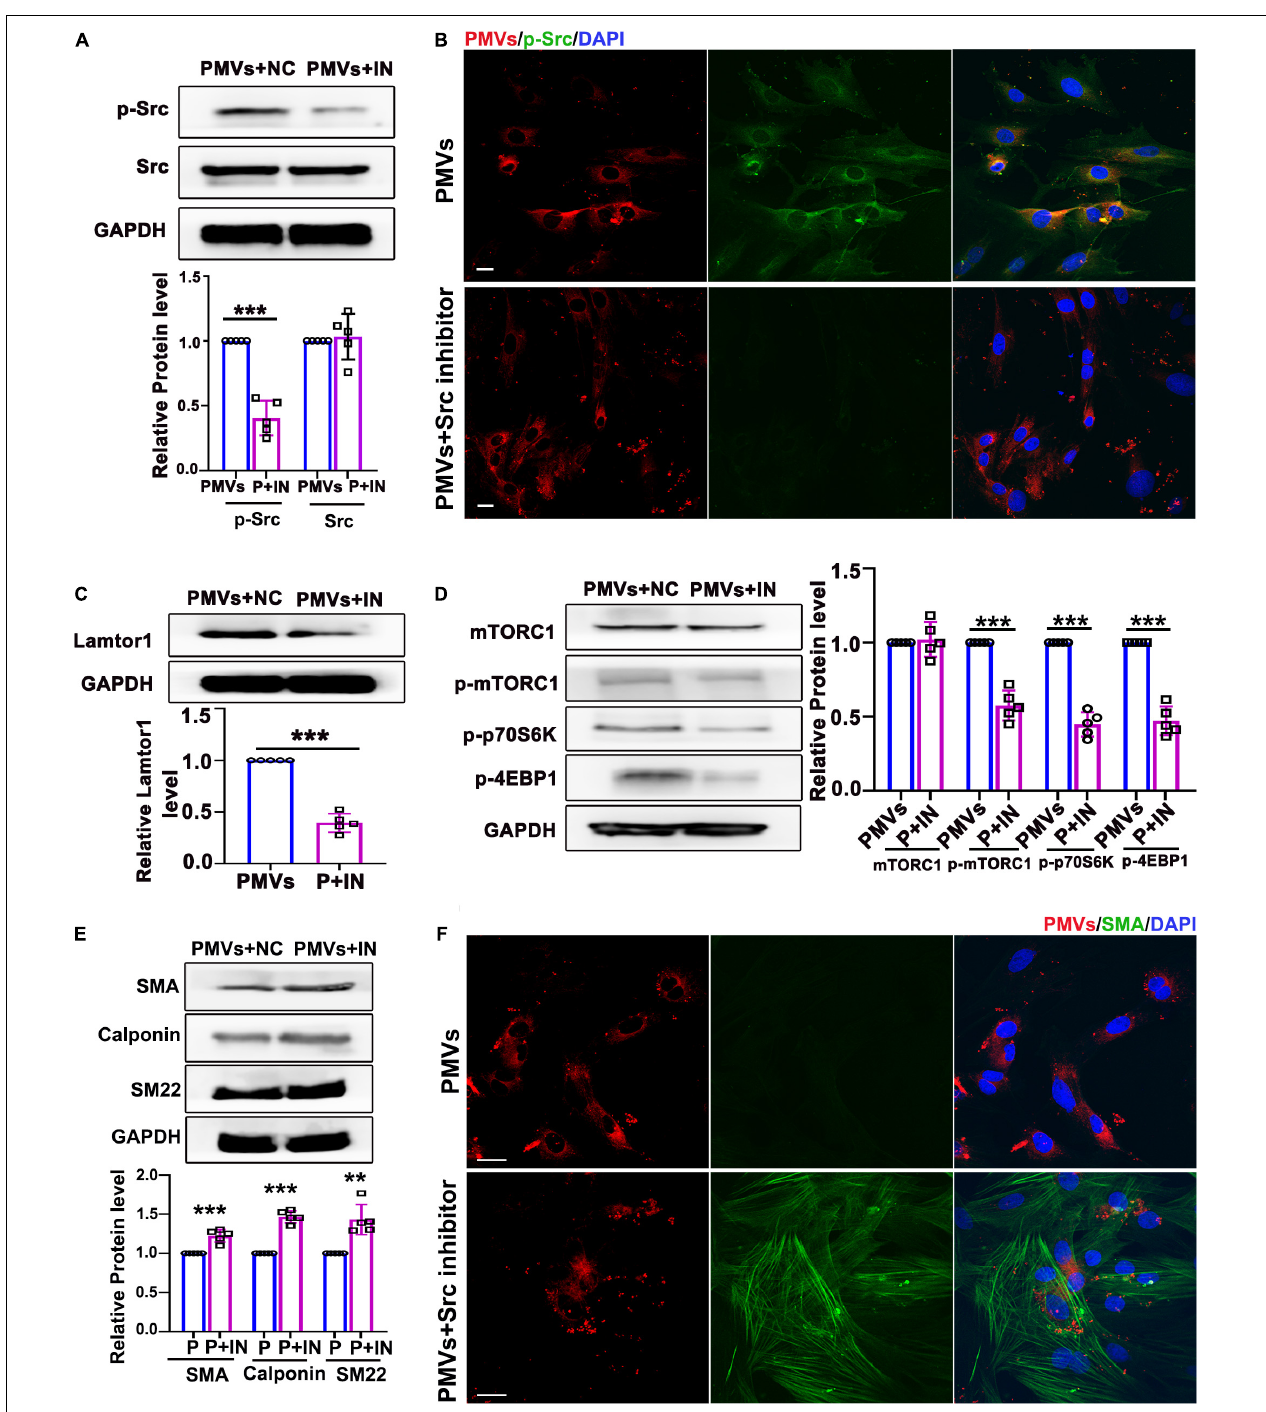
FIGURE 4 | Inhibition of p-Src repressed VSMC dedifferentiation via decreasing Lamtor1 expression and mTORC1 activity. (A) Src inhibitor (IN) decreased the phosphorylation of Src induced by PMVs, while did not change the expression of total Src ( n = 5). Data represent mean ± SD . *** P < 0.001. (B) Immunofluorescence staining confirmed that the phosphorylation of Src (green) was decreased after incubated with Src IN. Nuclei were counterstained with DAPI (blue). Scale bars: 50 µ m. (C) Src IN suppressed the protein expression of Lamtor1 induced by PMV stimulation ( n = 5). Data represent mean ± SD . *** P < 0.001. (D) Src IN inhibited phosphorylations of mTORC1, 4EBP1 and p70S6K induced by PMVs, while the expression of total mTORC1 was not changed ( n = 5). Data represent mean ± SD . *** P < 0.001. (E) Western blot revealed that Src IN increased the expressions of VSMC differentiation markers, i.e., SMA, calponin and SM22, ( n = 5). Data represent mean ± SD. ** P < 0.01, *** P < 0.001. (F) Immunofluorescence staining confirmed that Src inhibitor increased the expression of SMA (green). Nuclei were counterstained with DAPI (blue). Scale bars: 50 µ m.